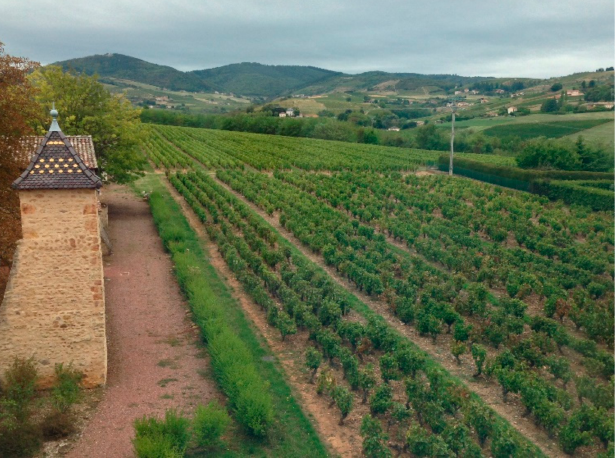
Figure 2. Claude Bernard’s family’s pigeon house and vines in Saint Julien in Beaujolais.